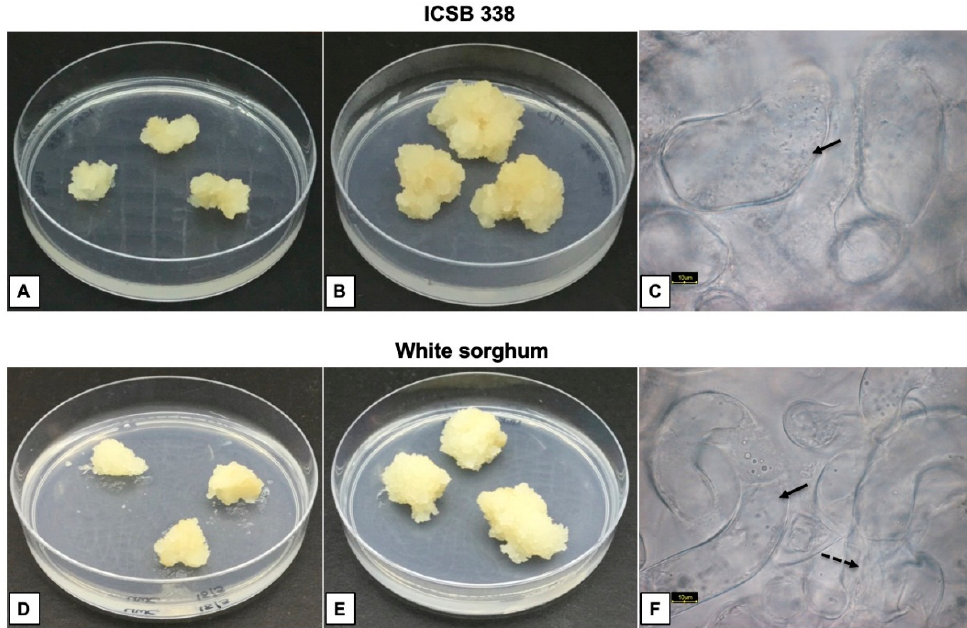
Figure 2. Maintenance of friable callus and its light microscopic analysis. ( A ) ICSB 338 calli immediately after sub ‐ culture. ( B ) The same ICSB 338 calli four ‐ weeks post sub ‐ culture. ( C ) Microscopic image of ICSB 338 callus. ( D ) White sorghum calli immediately after sub ‐ culture. ( E ) The same White sorghum calli four ‐ weeks post sub ‐ culture. ( F ) Microscopic image of White sorghum callus. Black arrows indicate individual cells whereas dotted arrow indicate cell clusters. The microscopic images were taken using a Nikon E2000 light microscope fitted with a Nikon DMX 1200 digital camera (Nikon, Tokyo, Japan). The scale bar is 10 μ m.